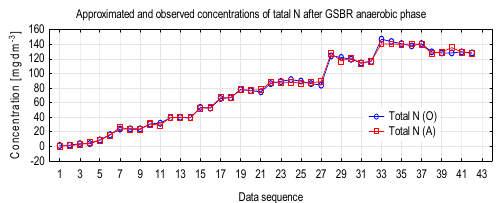
Figure 5. Approximated and observed concentrations of total N after sequence bath reactor with aerobic granular activated sludge (GSBR) anaerobic phase.